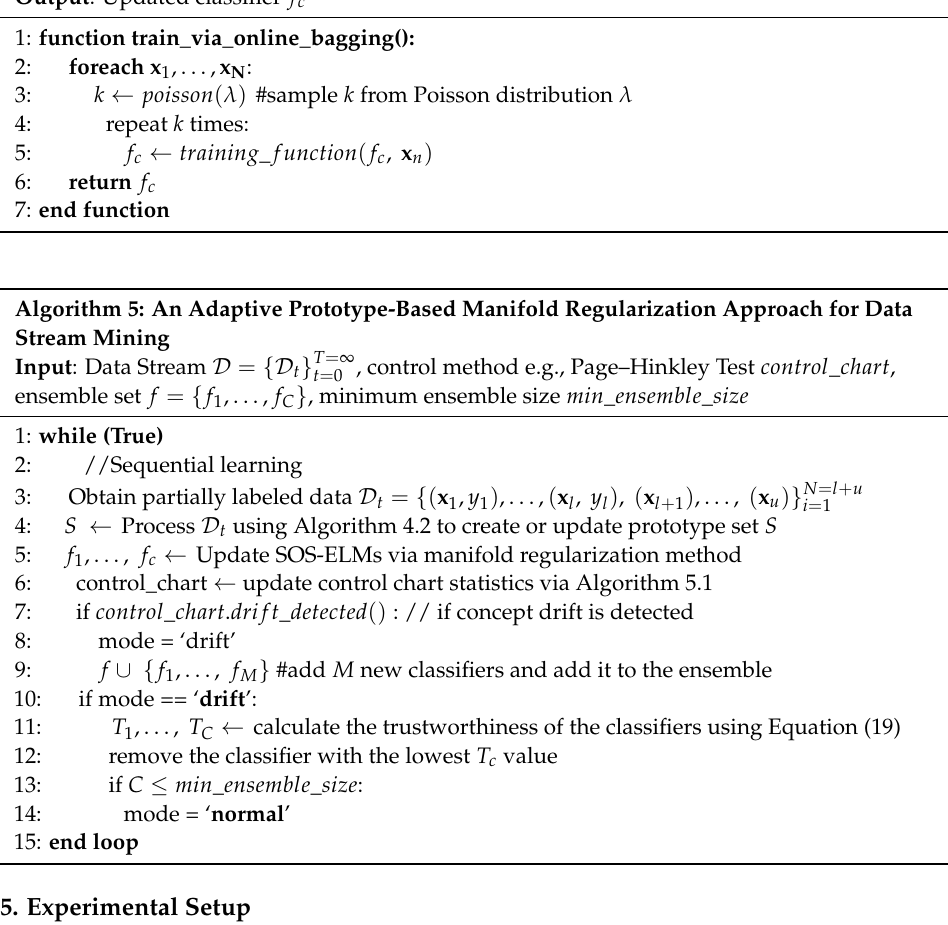
Algorithm 4: Online Bagging